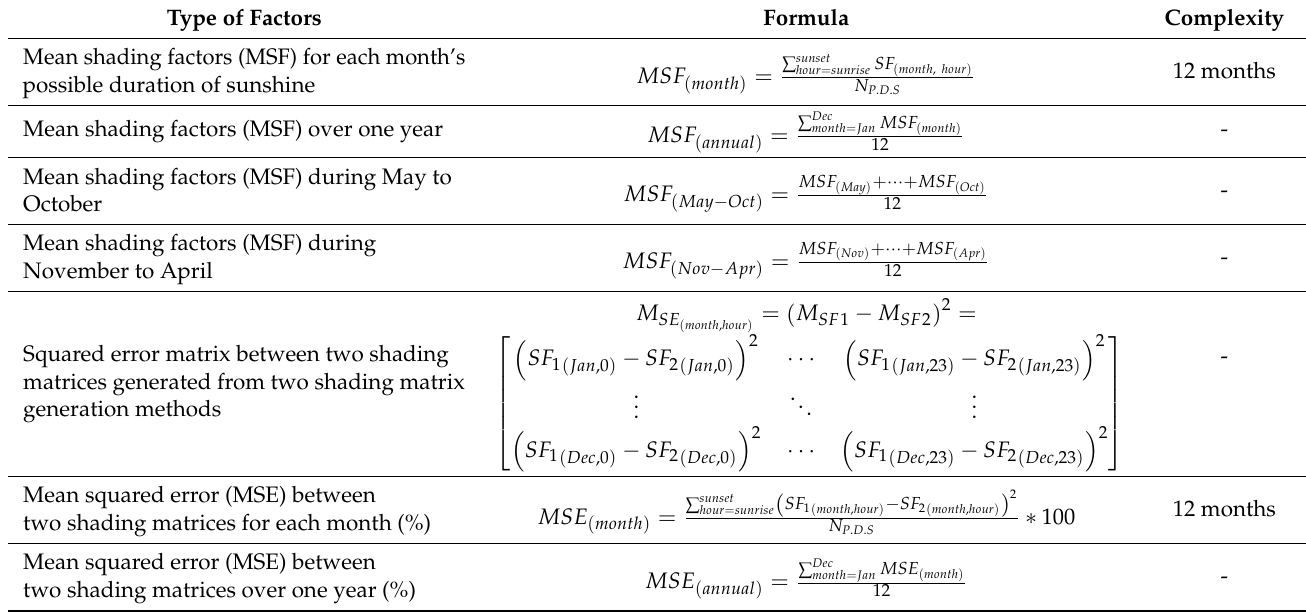
Table 3. Equations for calculation of factors used to compare the shading